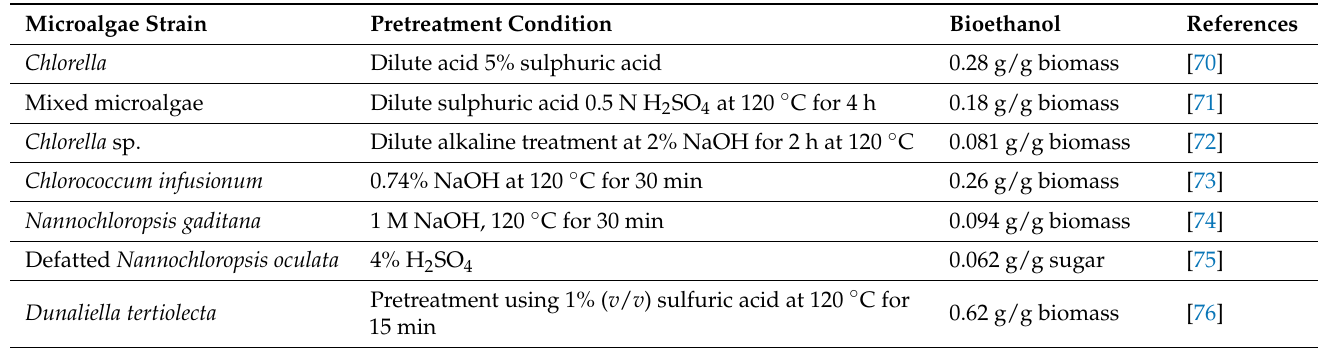
Table 4. Bioethanol production from different microalgal biomass